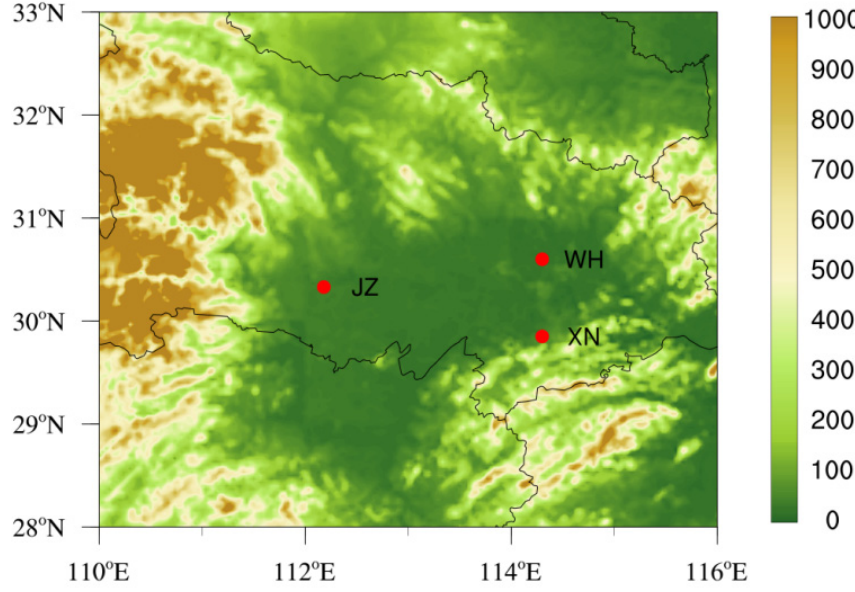
Figure 1. Study area and locations of Xianning (XN), Wuhan (WH) and Jingzhou (JZ) stations.